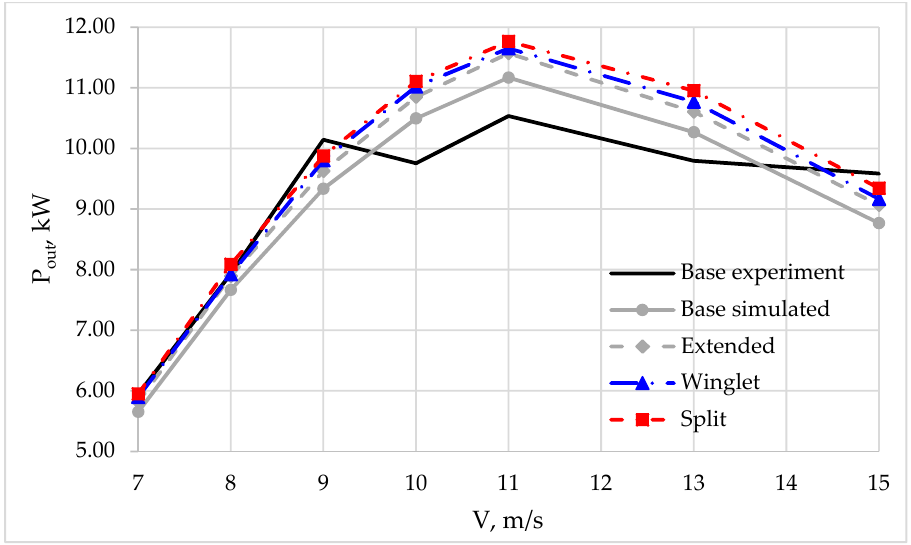
Figure 5. Power generation results from the experimental runs done by NREL and from the simulated runs.